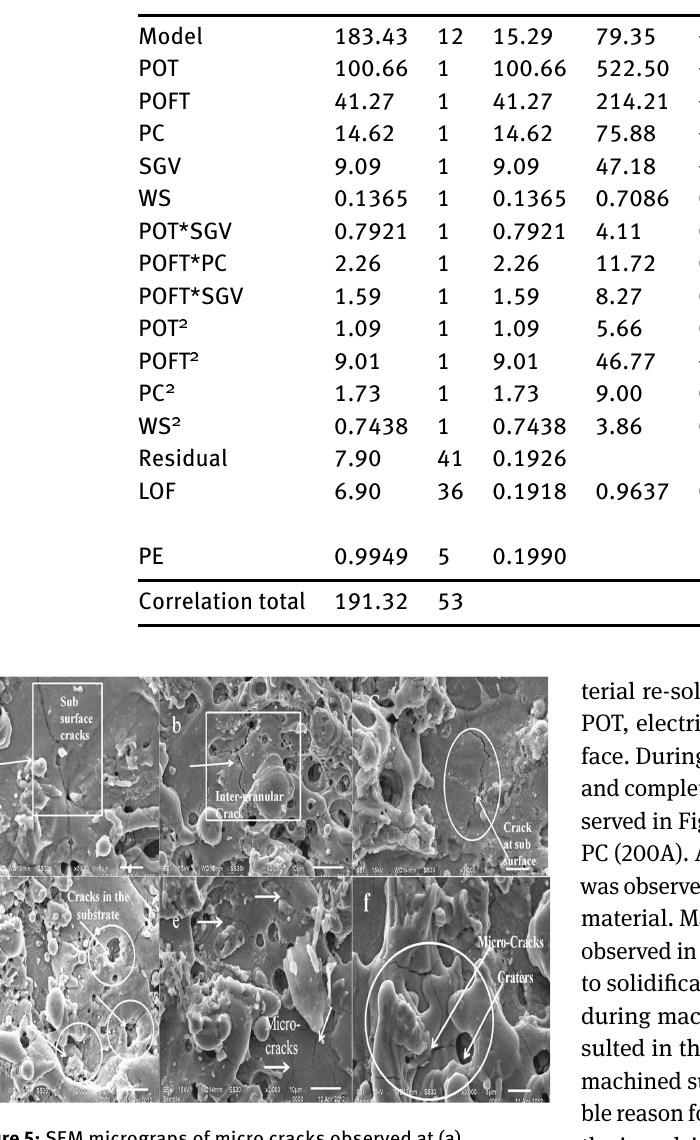
Figure 5: SEM micrograps of micro cracks observed at (a) POT=0.7 µ s, POFT=17 µ s, PC=120A, (b) POT=0.9 µ s, POFT=28 µ s, PC=160A, (c) POT= 0.9 µ s, POFT=17 µ s , PC= 160A, (d) POT=1.1 µ s, POFT=28 µ s, PC=160A, (e) POT=1.1 µ s, POFT=38 µ s, PC=200A, (f) POT=1.1 µ s, POFT=38 µ s,